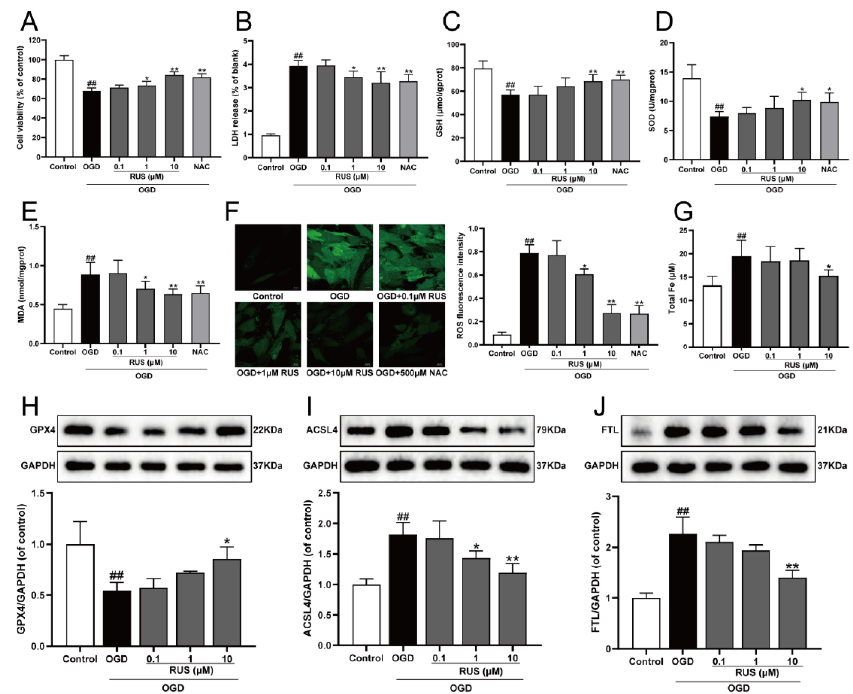
Figure 2. RUS significantly protected OGD-injured H9c2 cardiomyocytes and inhibited oxidative stress and ferroptosis. ( A ) The cell viability of H9c2 cardiomyocytes ( n = 6). ( B ) The LDH release of H9c2 cardiomyocytes ( n = 6). The contents of ( C ) GSH, ( D ) SOD and ( E ) MDA in H9c2 cardiomyocytes ( n = 6). ( F ) Immunofluorescence analysis of ROS production in H9c2 cardiomyocytes (scale bar, 20 µm, n = 3). ( G ) The content of total iron in H9c2 cardiomyocytes ( n = 6). Representative Western blotting analysis of ( H ) GPX4, ( I ) ACSL4, and ( J ) FTL in H9c2 cardiomyocytes ( n = 3–4). Results were expressed as mean ± SD. ## p < 0.01 vs. the control group, * p < 0.05, ** p < 0.01 vs. the OGD group.